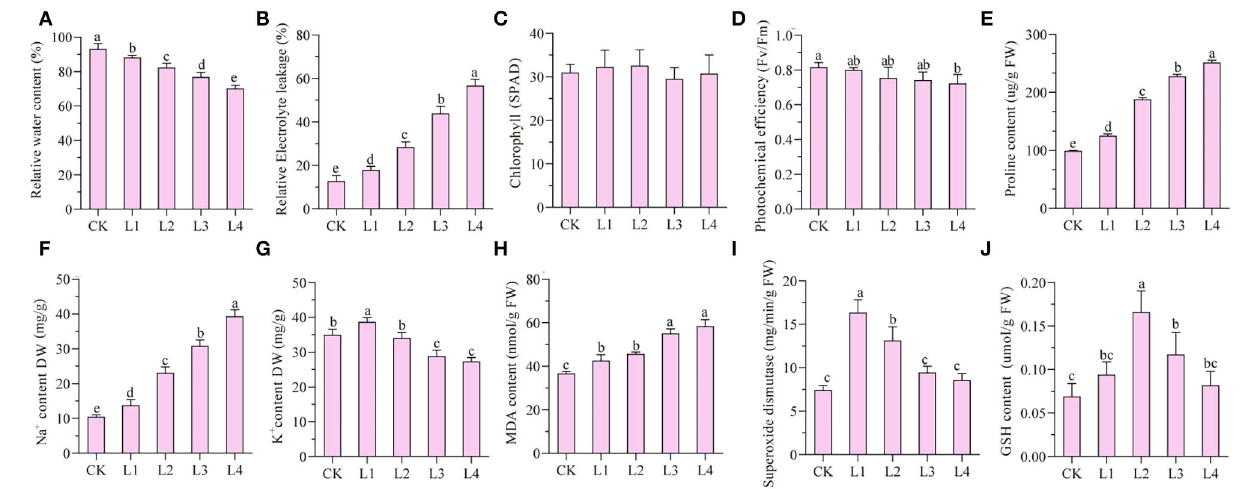
FIGURE 1 | Analyses of dynamic physiological effects under 300mM NaCl stress in the leaves. CK: untreated control; L1: salt stress treatment for 12h; L2: 24h; L3: 36h; L4: 48h. (A) rRelative water content; (B) relative electrolyte leakage; (C) chlorophyll content (SPAD); (D) photochemical efficiency; (E) proline content; (F) Na + content; (G) K + content; (H) MDA content; (I) superoxide dismutase; (J) GSH content.